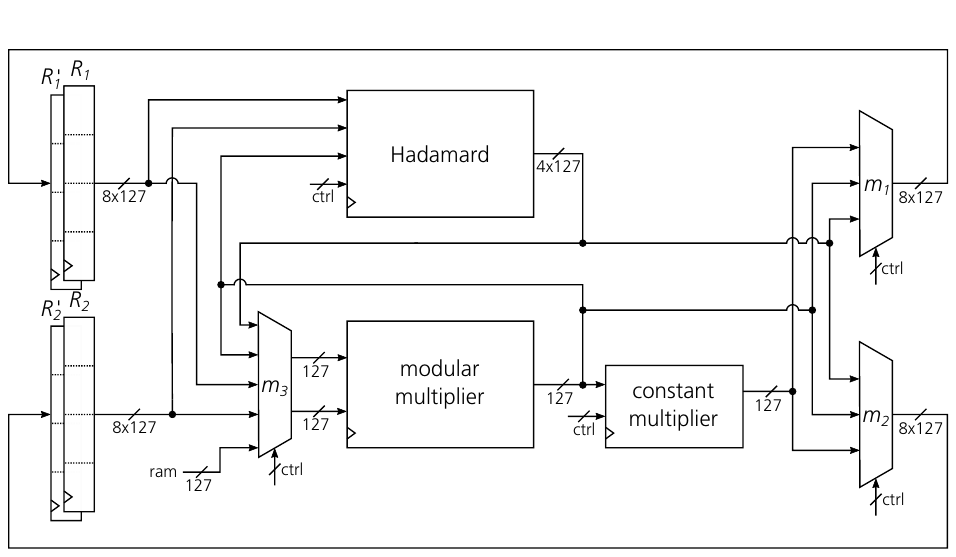
Figure 2: Datapath including register